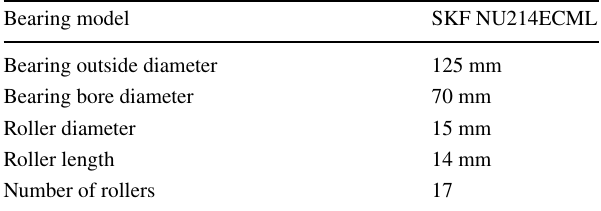
Table 1 Specifications of the instrumented bearing Bearing model